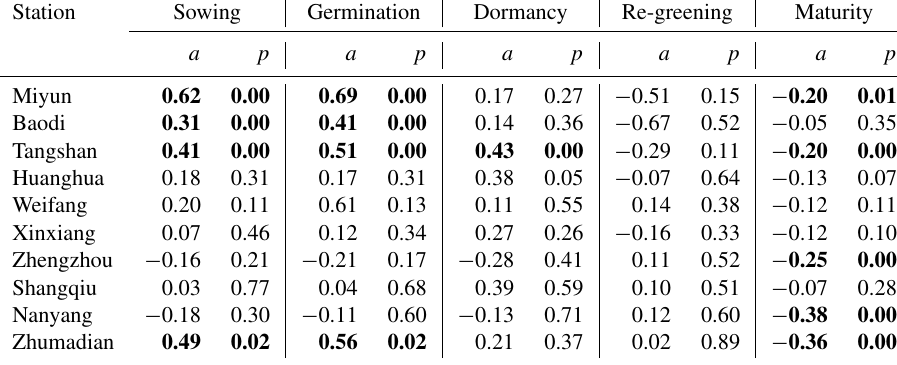
Data are shown as the average ± standard deviation. Table 4. Linear trends in winter wheat phenology.